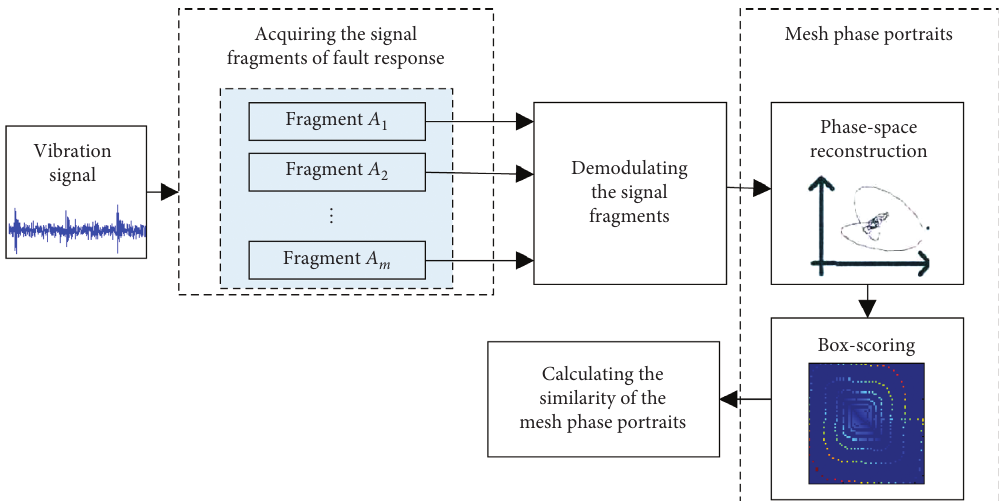
Figure 1: Method frame for calculating the similarity of fault signal fragments under variable